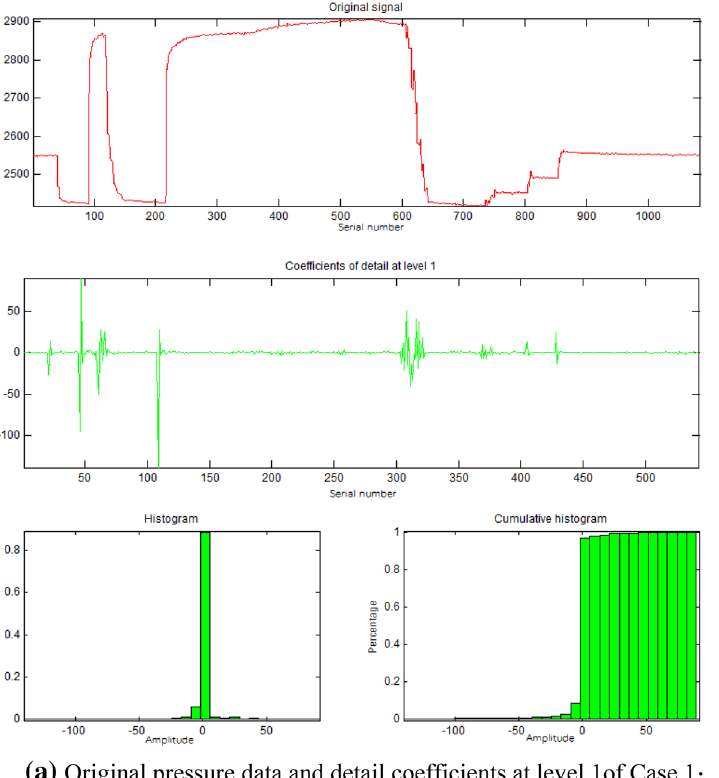
Fig. 3 PDG pressure data of Case 1 and 2. a Original pres- sure data and detail coefficients at level 1of Case 1; b original pressure data and detail coef- ficients at level 1 of Case